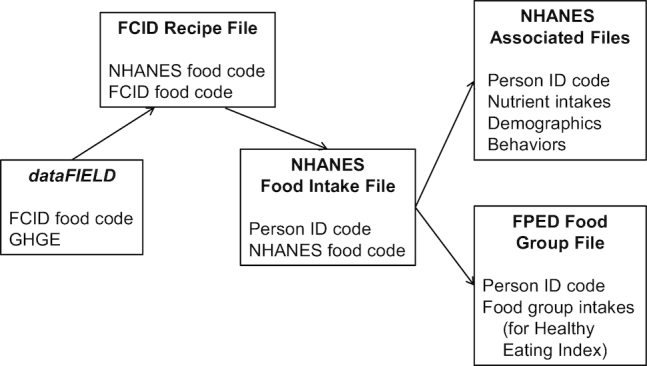
Schematic of how environmental impact data were linked to food, nutrient, demographic, and behavioral variables. dataFIELD, database of Food Impacts on the Environment for Linking to Diets; FCID, Food Commodity Intake Database; FPED, Food Pattern Equivalent Database; GHGE, greenhouse gas emissions.